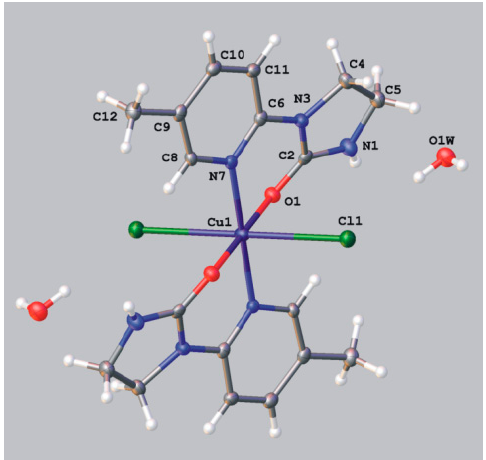
Figure 6. ORTEP representation of molecular structure of 9 . Displacement ellipsoids are shown at the 50% probability level. Only symmetry independent part is